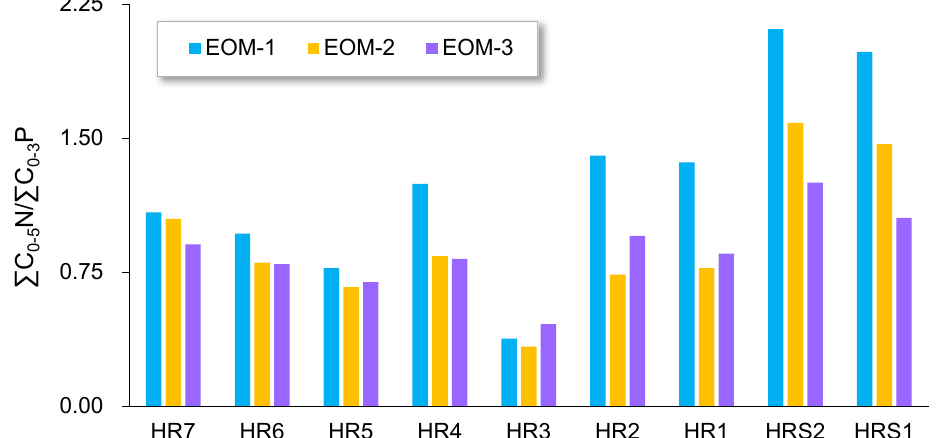
Figure 9. Concentration distributions and ratios of n -alkanes in sequential extracts of the studied samples: ( a ) EOM-1; ( b ) EOM-2; ( c ) EOM-3; ( d ) ∑ C 20 − / ∑ C 21+ ratio.